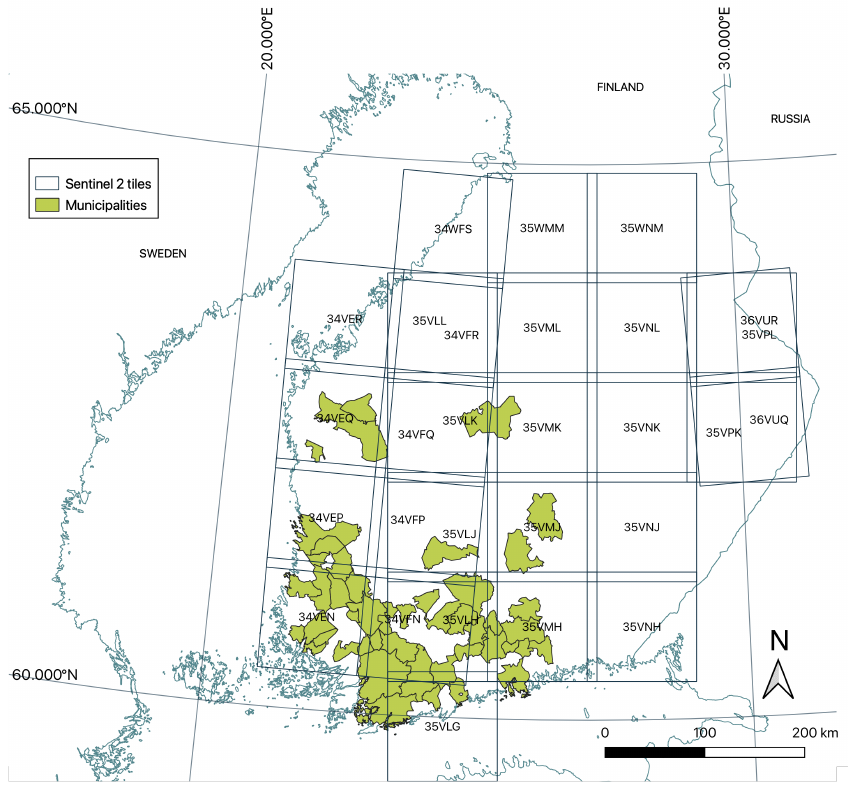
Figure 1. Study area is determined by 28 Sentinel-2 tiles. Selected regions (municipalities) are used in the study to validate regional-level yield predictions. Note that multiple Sentinel-2 tiles on adjacent orbits can overlay a